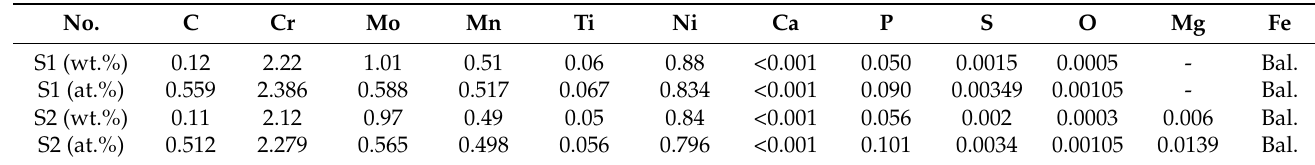
Table 1. Chemical composition of the